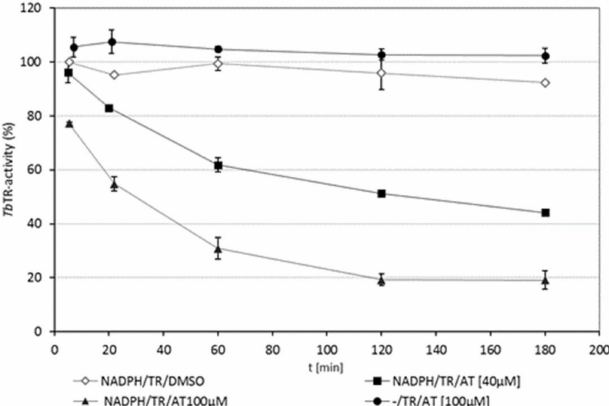
Figure 3. Time-dependent inhibition of Tb TR by STL 1 (AT). The solvent (blank control, open diamond) or the STL (40 [filled square] and 100 µ M [filled triangle]) was incubated with TR in the presence of NADPH; the STL was also incubated with TR in the absence of NADPH (filled circle). Samples were taken at the di ff erent time points, and the remaining activity was measured in a standard TR assay containing 100 µ M NADPH and 100 µ M TS 2 (data represent the averages of two independent determinations ± deviations from the